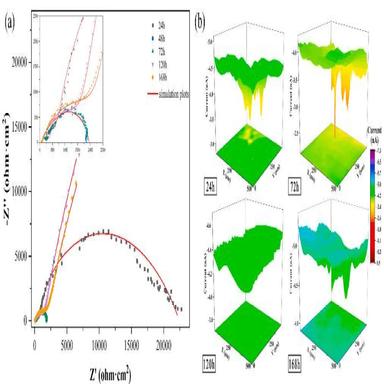
(a) Nyquist plots and (b) SECM mappings of the ED sample during immersion in SBF.